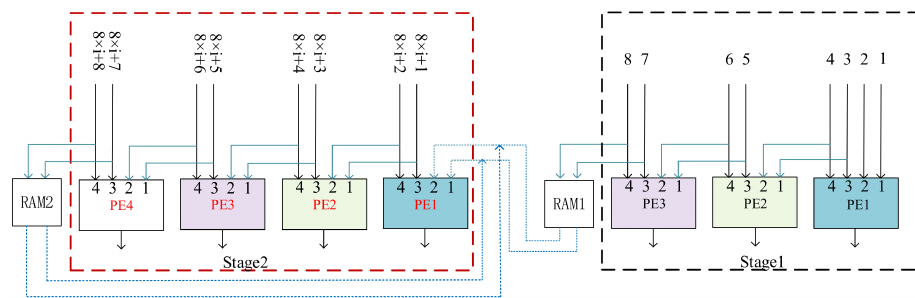
Figure 3. Parallel channels method by caching input